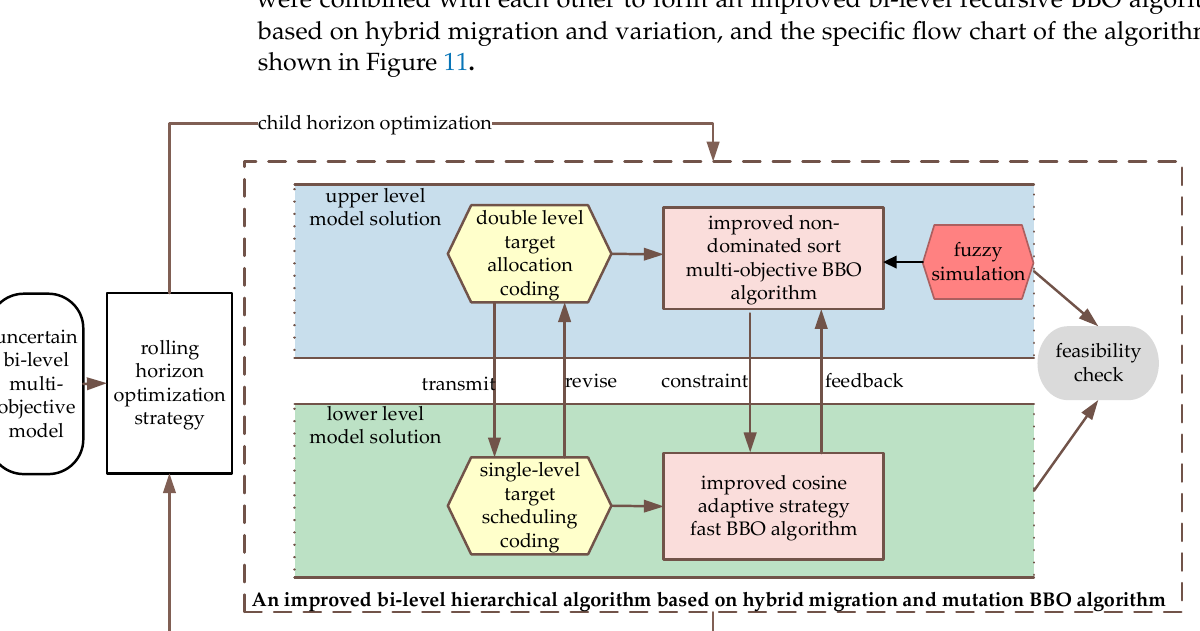
Figure 11. Flow chart of the improved two-layer recursive BBO algorithm based on hybrid migration and variation.